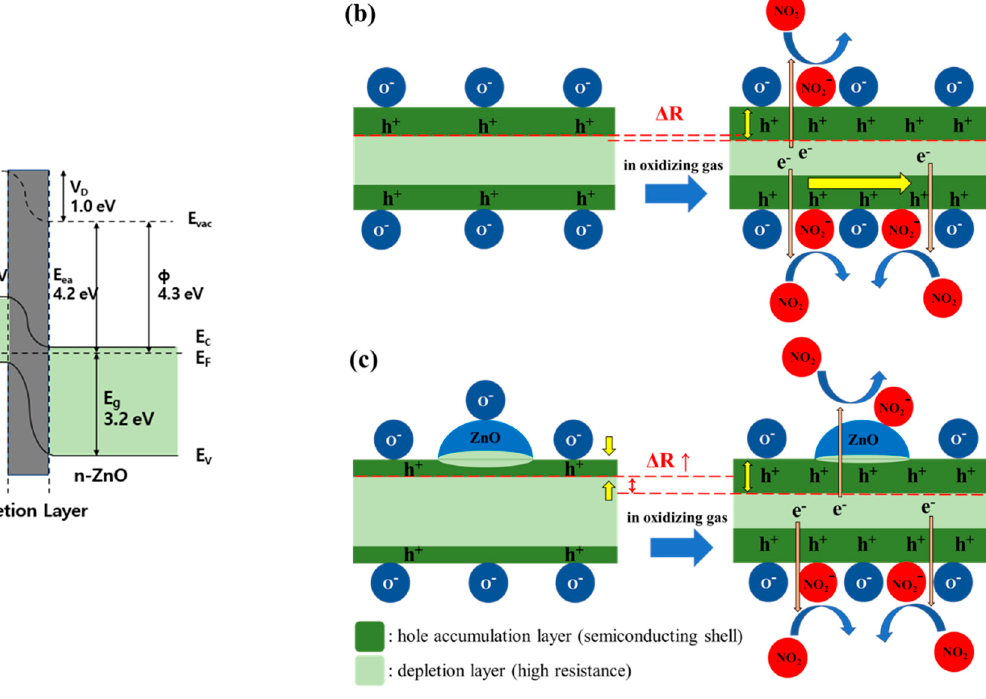
Figure 5. Schematic view of the effects caused by the CuO/ZnO heterojunction. ( a ) Diagram of the p-CuO and n-ZnO heterojunction band; ( b ) Reaction of a CuO NW to NO 2 gas; ( c ) Reaction of a CuO NW with ZnO heterojunction to NO 2 gas.